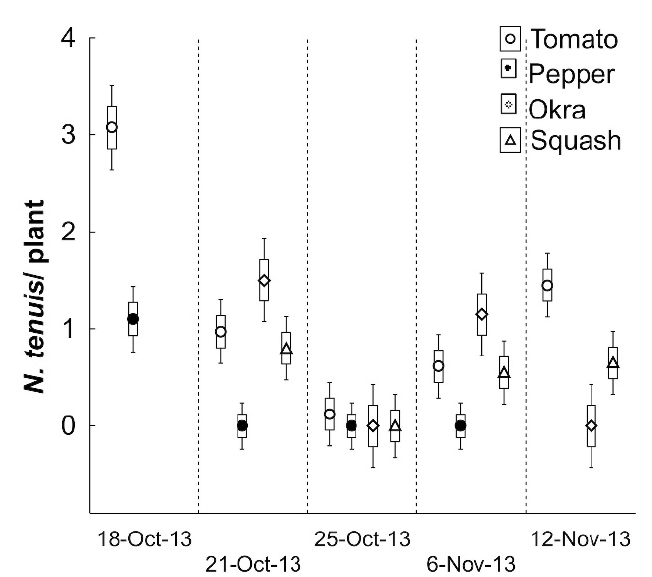
Figure 3. Introduction phase of Nesidiocoris tenuis on vegetable fields in Edinburg, TX, USA. Plot data points shown means, standard errors, and 95% confidence intervals of N. tenuis on tomato, pepper, okra, and squash fields.